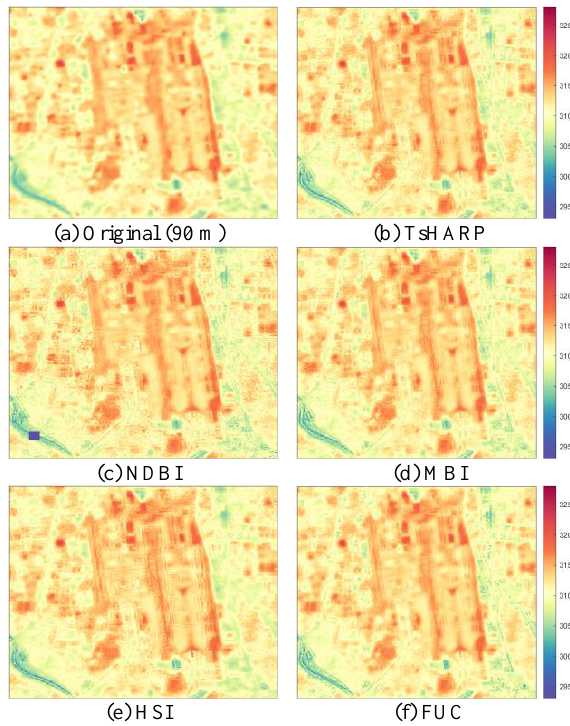
Figure 5. Sharpened images of the Beijing Capital International airport from 06/14/2019 images using urban indices.